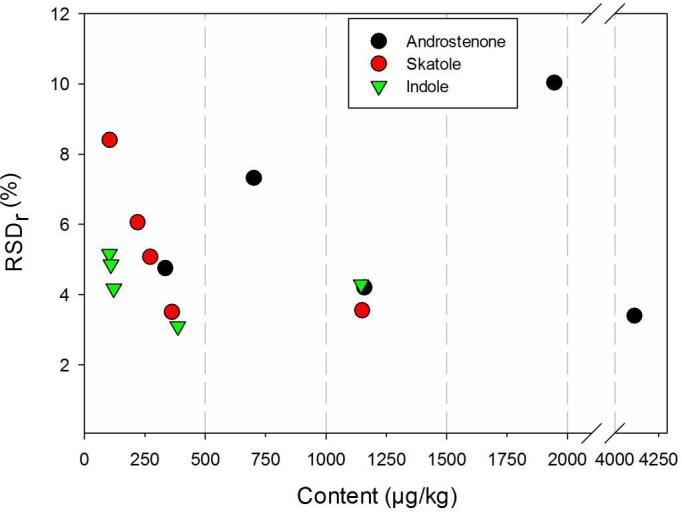
Dependence of repeatability relative standard deviation (RSDr) on analyte content.